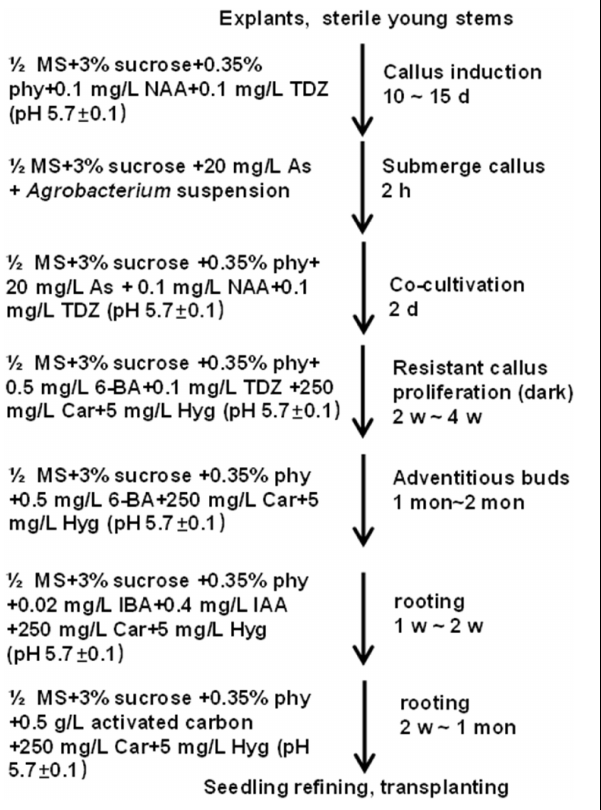
FIGURE 8 | Stepwise protocol for transforming Casuarina equisetifolia using stem segments as the